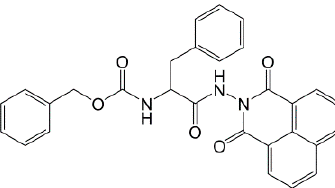
Figure A4. N -Methyl- N -(pentacosa-10,12-diyn)-propargylamine. For synthesis see reference [27].